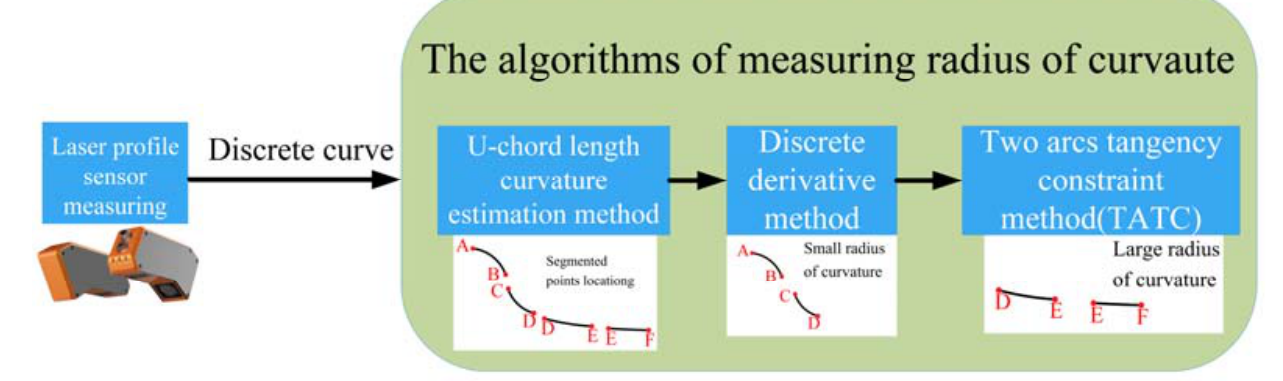
Figure 3. The procedure for measuring wheel profile radius of curvature.